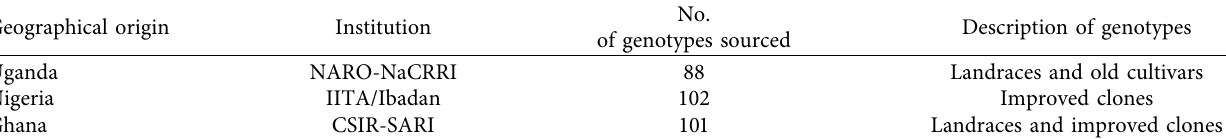
Table 1: Description of yam